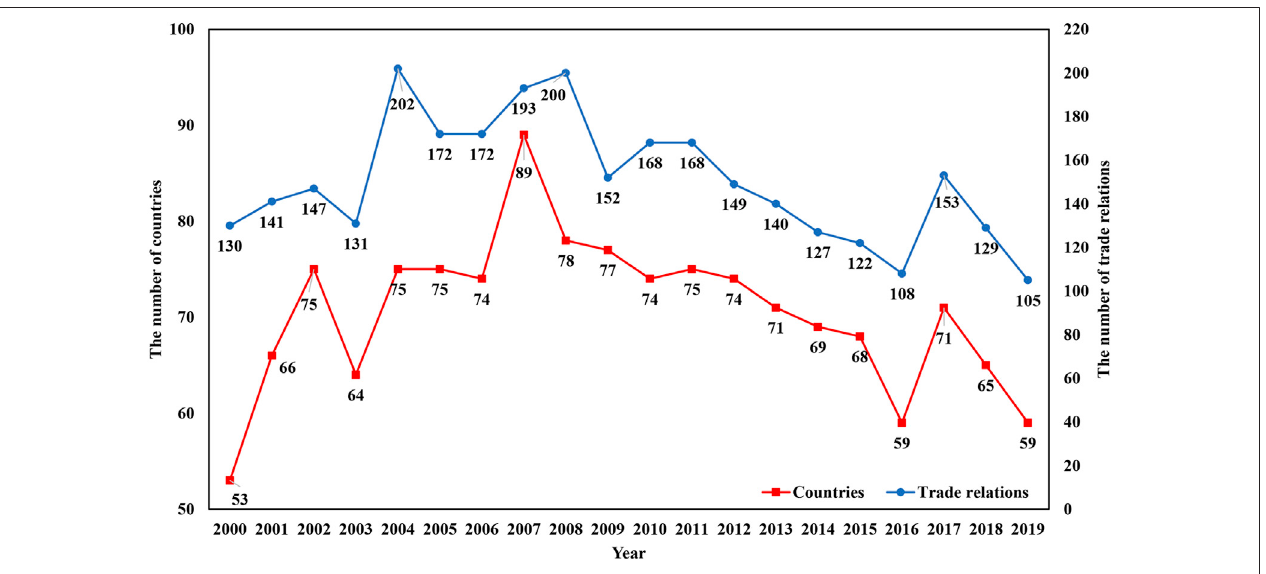
FIGURE 2 | The number of countries and trade relations in CIDN and CEDN from 2000 to 2019.